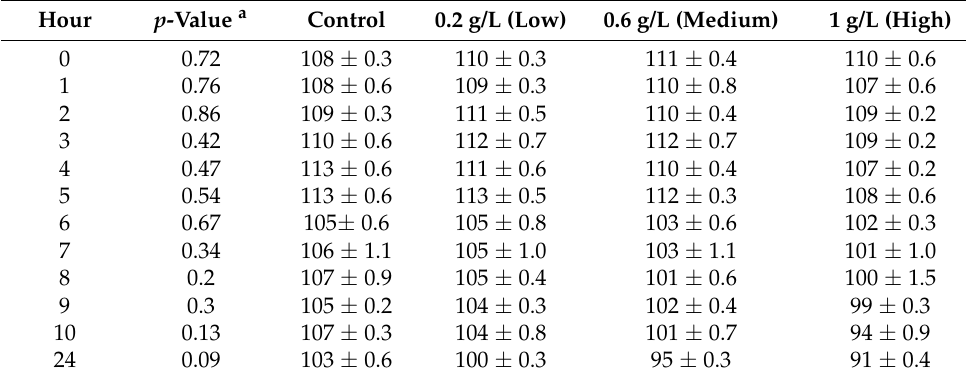
Table 2. Initial glucose (g/L) values over the first 24